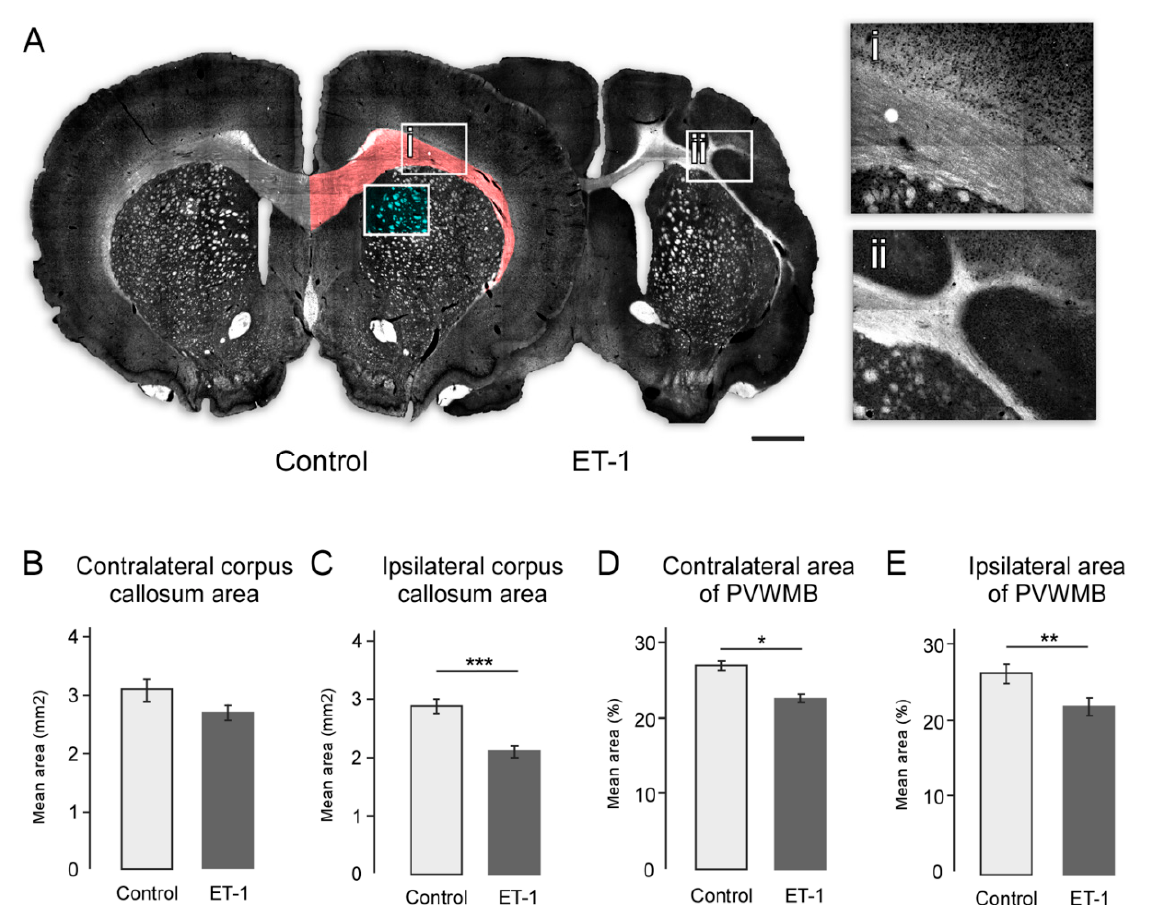
Figure 3. Changes to the size and morphology of major white matter tracts following neonatal ischemia. ( A ) Representative darkfield images of coronal sections from a control and ET-1 group illustrate changes to white matter, with the area used for quantification for corpus callosum (red) and PVWMBs (cyan) indicated and boxed areas enlarged to show normal morphology of the corpus callosum for control animals ( i ) in comparison with the gross morphological changes following neonatal ischemia ( ii ). 20X magnificaiton ( B , C ) Quantification of area in coronal sections showed no change in contralateral corpus callosum ( B ) but a significant reduction in size of the ipsilateral corpus callosum ( C ) because of neonatal ischemia. Measurement of the size of the PVWMBs as the fractional contribution of white matter in a fixed field of view showed a significant reduction in PVWMB size in both the contralateral ( D ) and ipsilateral ( E ) hemispheres. Scale bar = 1 mm. Error bars = 1 SEM, * p < 0.01, ** p < 0.01, *** p < 0.001, independent t -test, (Group size: Control n = 7; ET-1 lesion n =